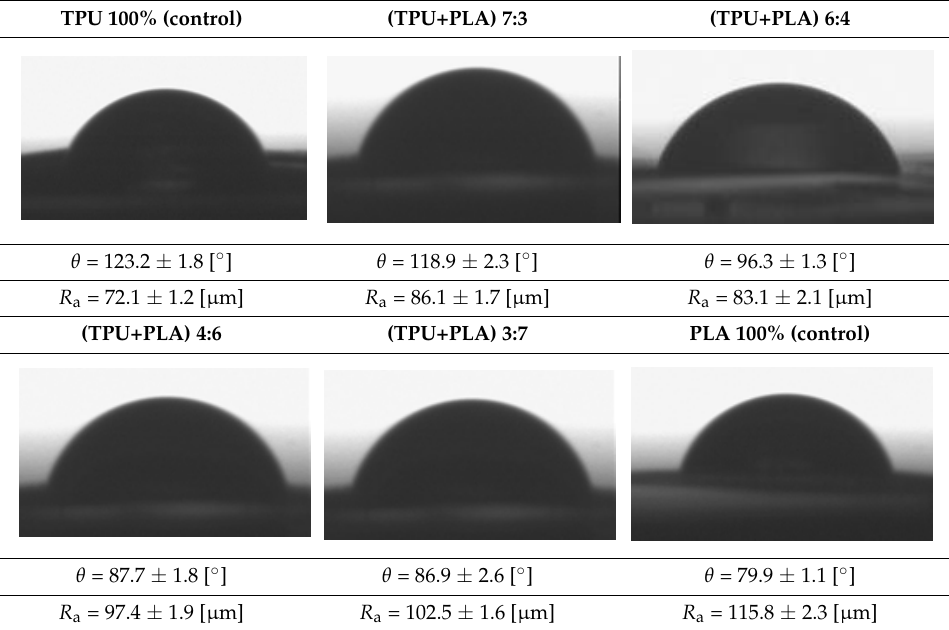
Table 2. The surface properties of polyurethane, poly(lactic acid), and their